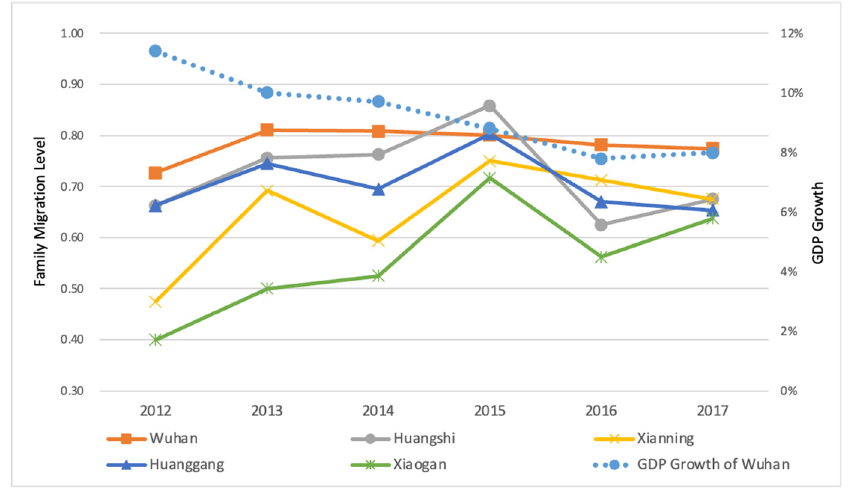
Figure 6. General trend of the family migration level in five cities and the GDP growth of Wuhan.